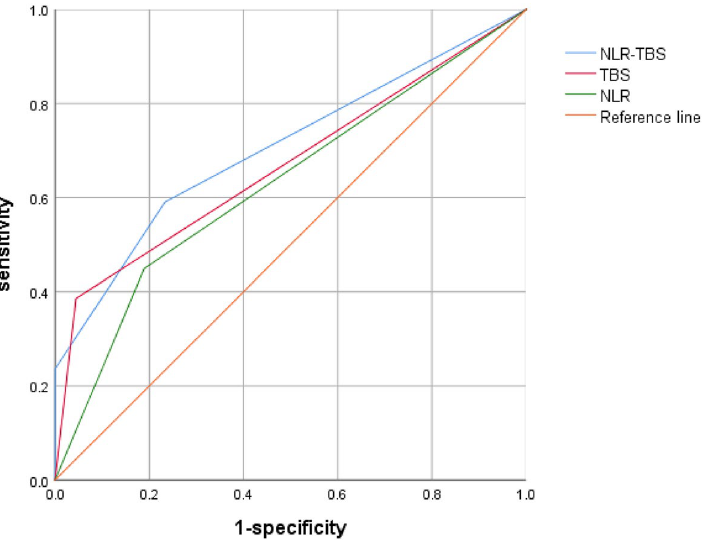
Figure 4. Comparison of NLR–TBS group, TBS group and NLR group in predicting recurrence.